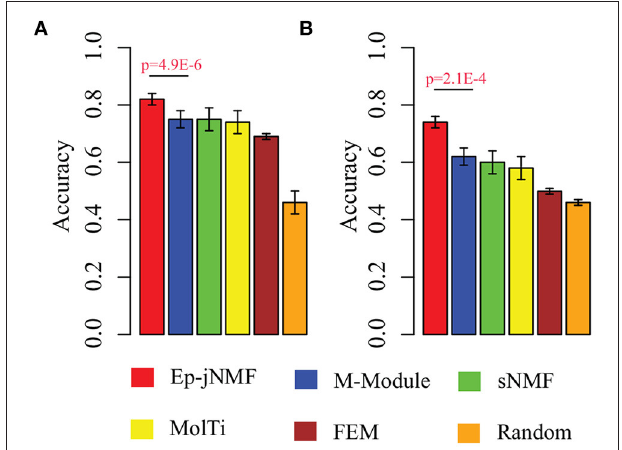
FIGURE 5 | Performance on the prediction of subtypes with various validation in terms of accuracy: (A) internal validation with the error bar as for the standard deviation and (B) external